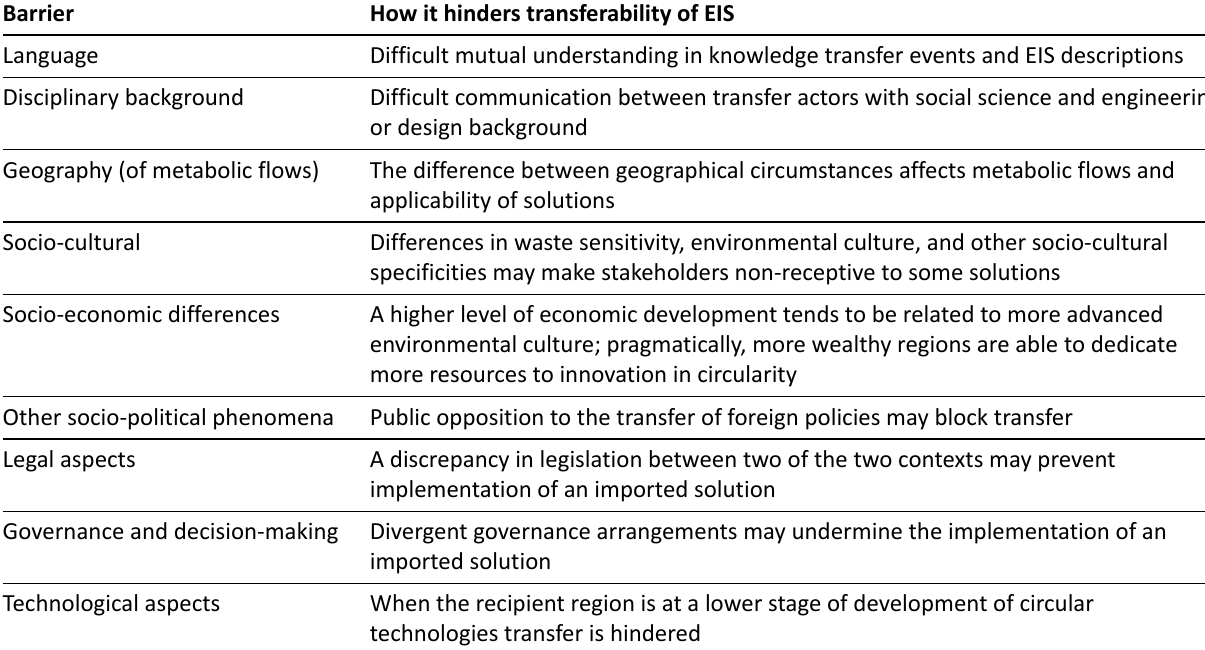
Table 1. Typology of barriers for knowledge transfer. Source: Adapted from REPAiR (2018c), building on Evans (2009), Heinelt et al. (2006), Marino, Parotta and Pozzoli (2016) and Schumacher (2015).